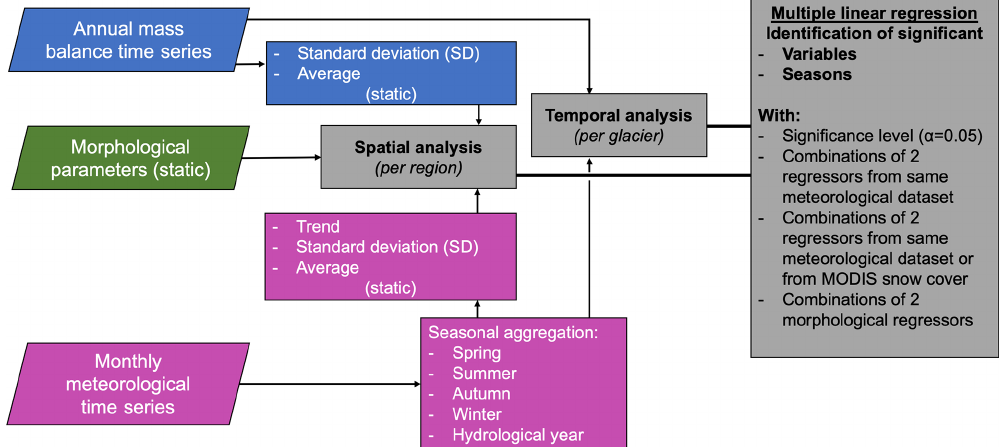
Figure 4. Workflow of spatial and temporal analyses using the mass balance estimates from Barandun et al. (2021a) and Hugonnet et al. (2021) and the meteorological data from the three different reanalysis products and MOD10CM snow cover (SC) as explained in the Data section. Focus in this study is to identify significant relationships rather than explain variance or other statistics. Therefore, identification of important variables and seasons is solely based on derived p values from multiple linear regression analyses. All significant correlations of a variable are used to produce the maps for the temporal analyses, and the reported relative importance in the spatial analysis is defined as the number of significant variables over the total number of tested variable combinations (see also Sect. 3).